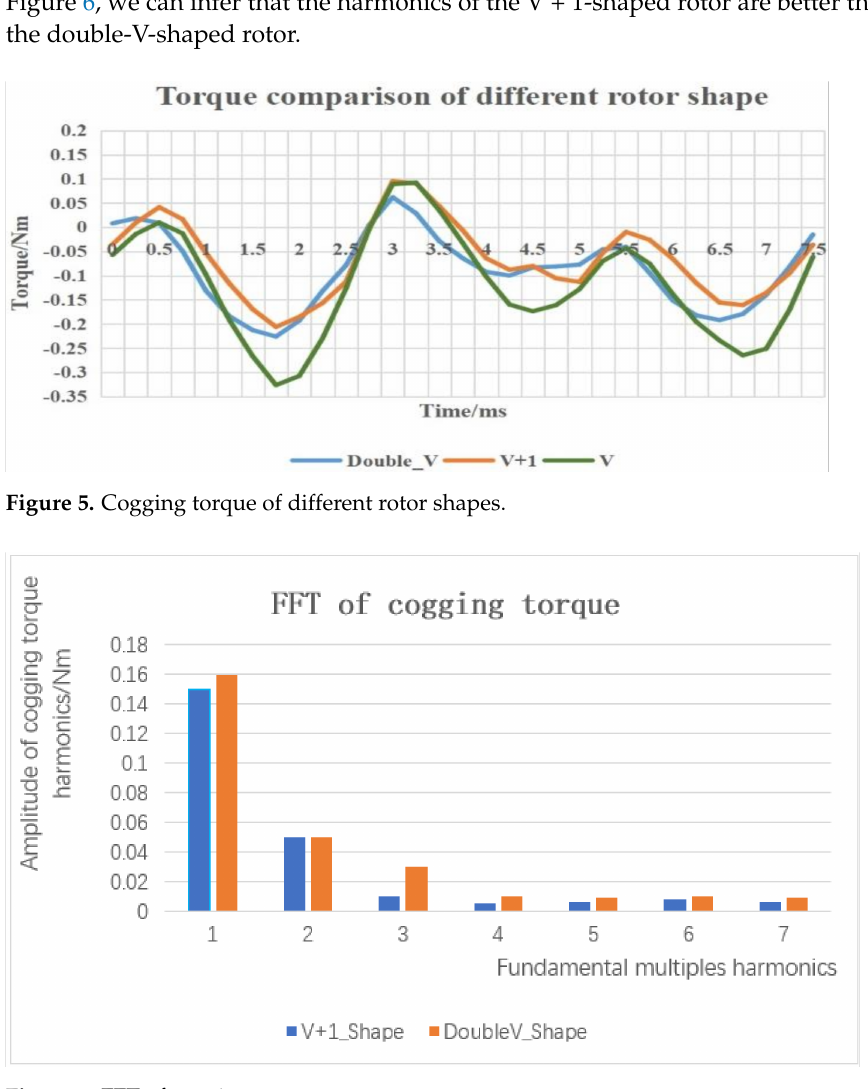
Figure 6. FFT of cogging